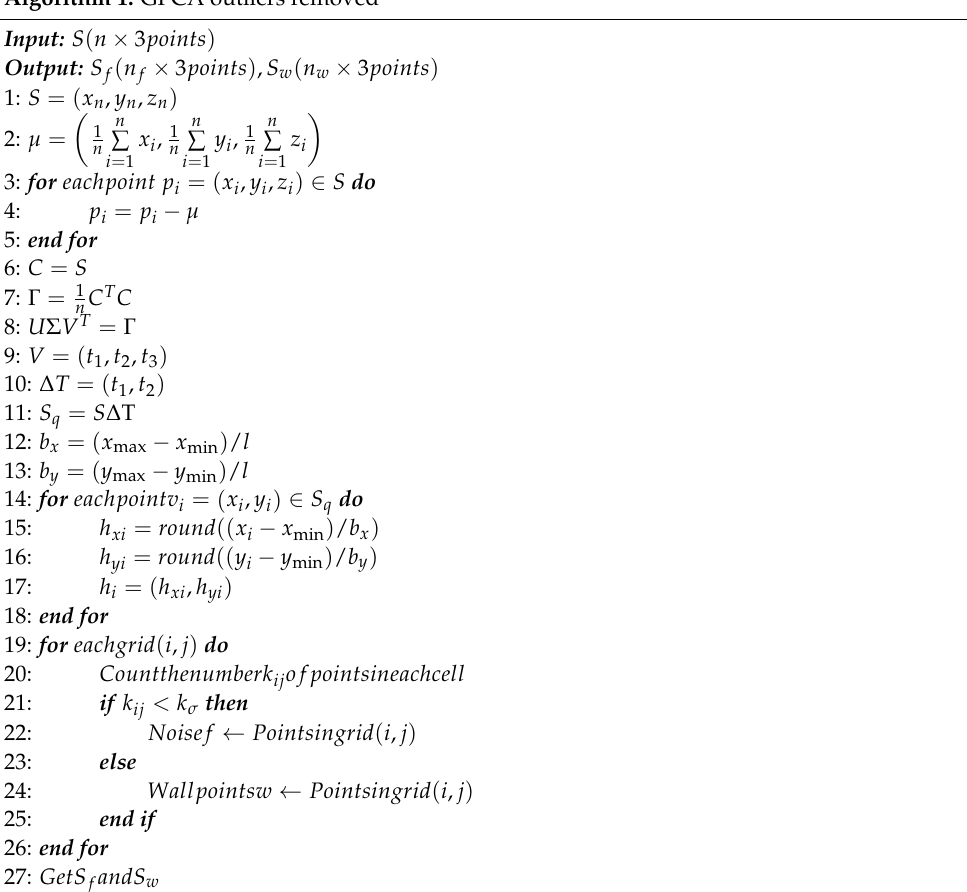
Algorithm 1. GPCA outliers